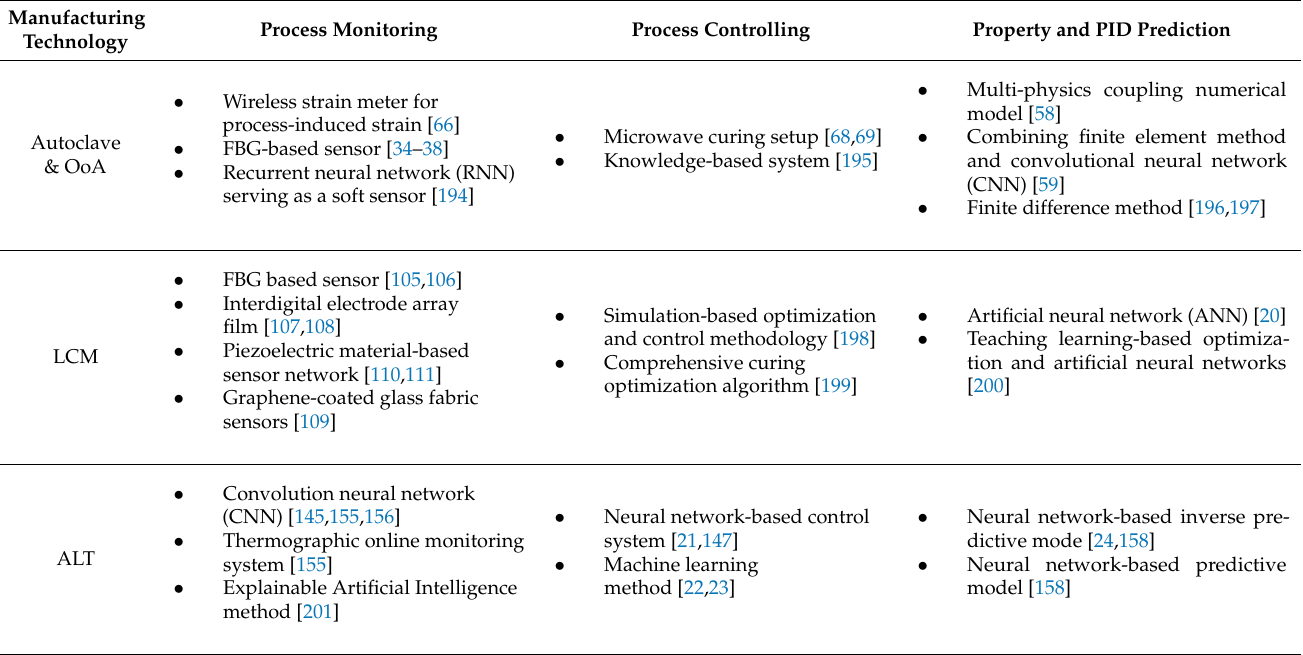
Table 4. Numeralization and intellectualization of manufacturing technologies for FRP